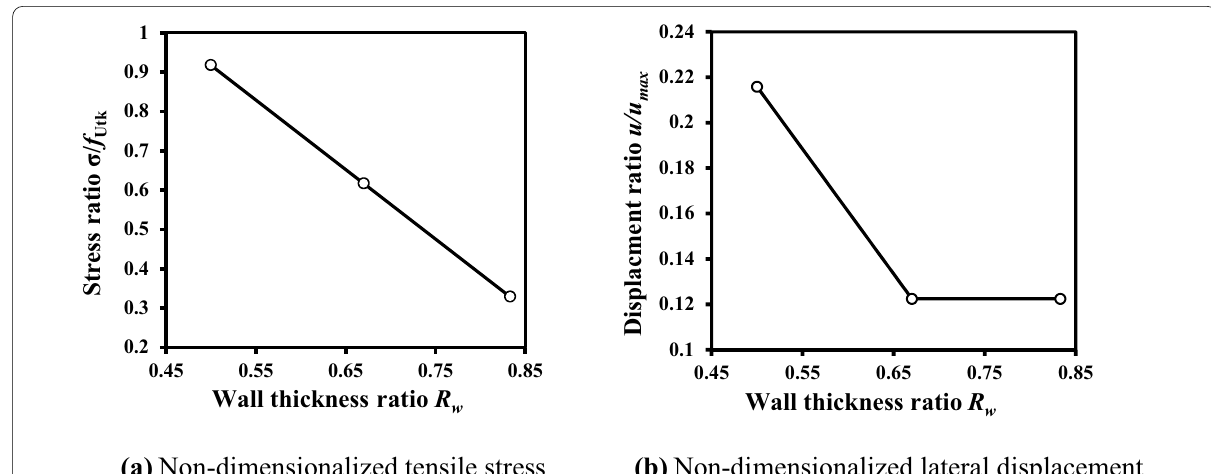
Fig. 10 Regression curves of the tensile stress and lateral displacement according to wall thickness ratio.